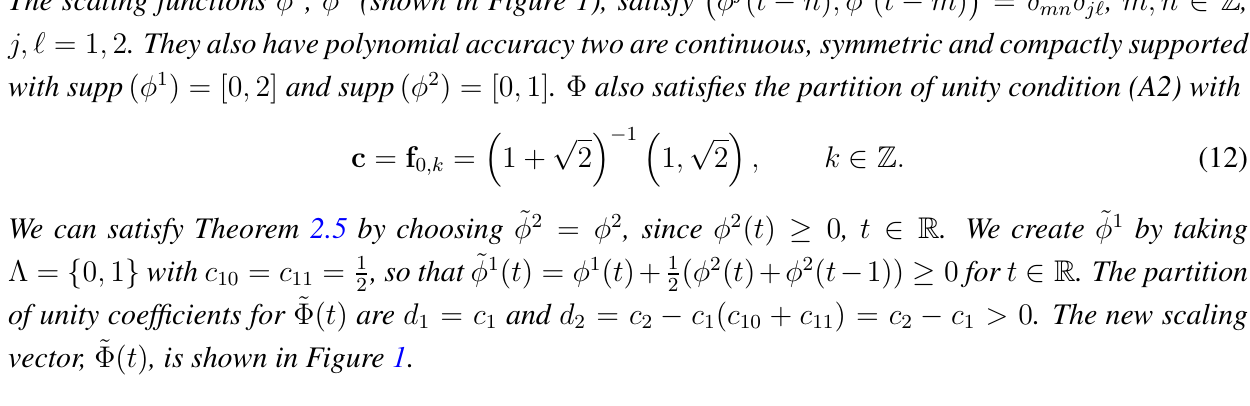
Figure 1. The scaling vector Φ (left) and the new scaling vector ˜ Φ from Example 2.6